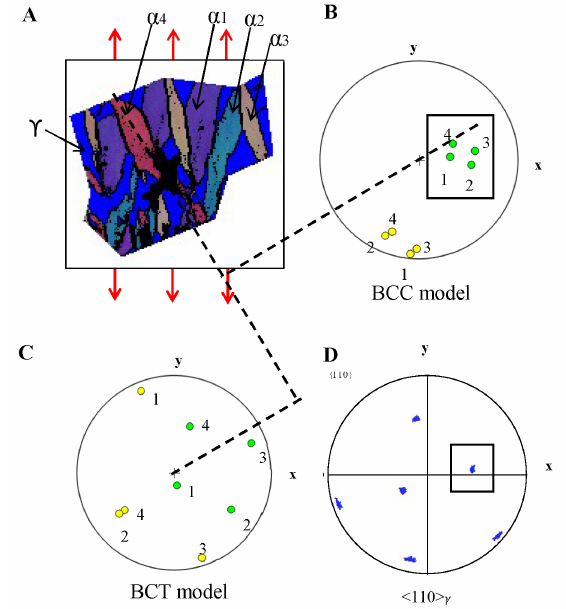
Figure 5. Trace analysis of the shape strain predicted by the Phenomenological Theory of Martensite Crystallography (PTMC) and variant selection prediction. ( A ) EBSD map of the grain with red arrows indicating the traction direction. The dashed lines indicate the normal to the habit plane of variant α 4 . ( B ) Pole figure of the normals to the habit planes (green) and the shear directions (yellow) predicted by the BCC model. ( C ) Pole figure of the normal to the habit planes (green) and the shear directions (yellow) predicted by the BCT model. ( D ) < 110 > γ experimental pole